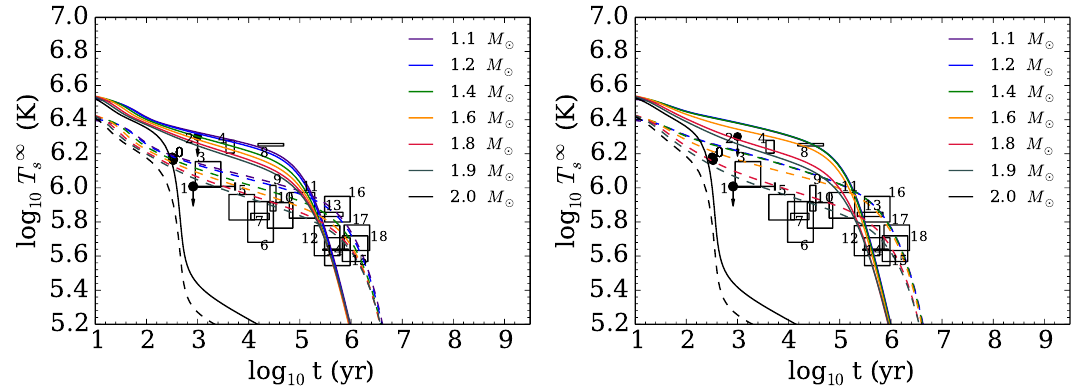
Figure 5. The same as Figure 4, but considering the effect of neutron superfluidity in the 1 S 0 channel via the SFB model [51] and proton superconductivity in the 1 S 0 channel with the AO model [53] (left panel) and CCDK model [55] (right